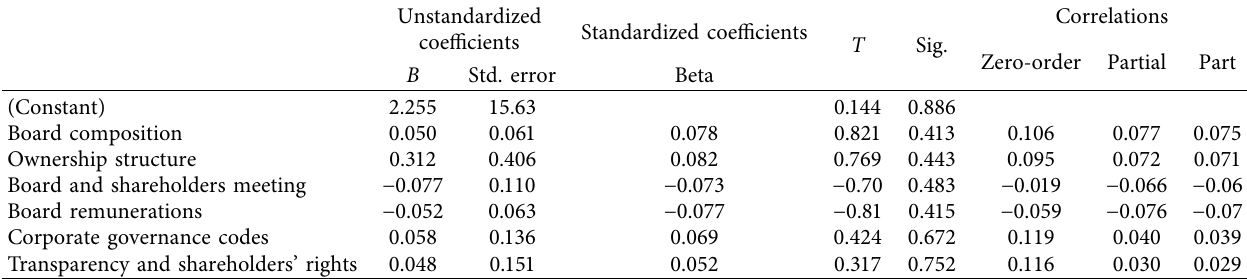
Table 7: Coefficients.